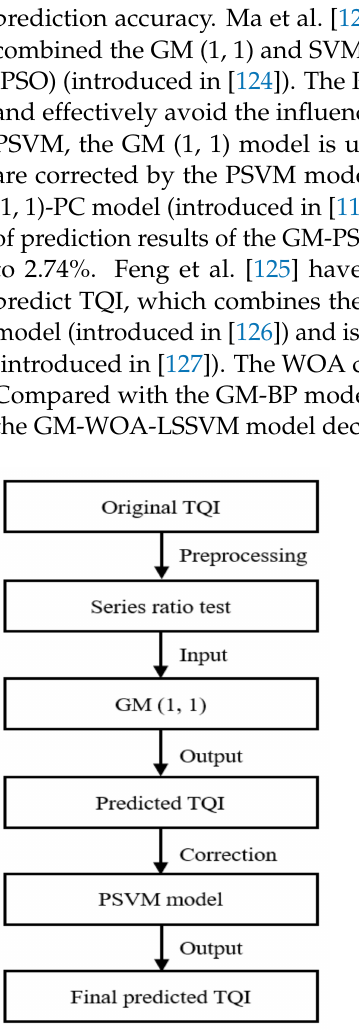
Figure 7. Structure of GM-PSVM